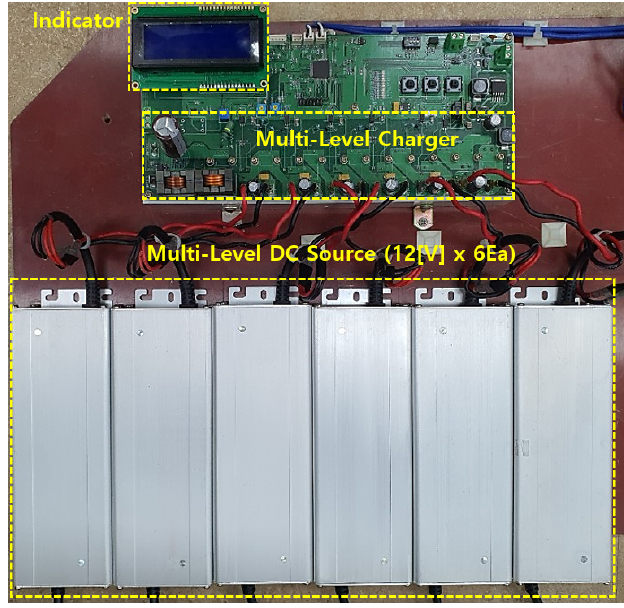
Figure 15. DPS-MLC used for the experiment.